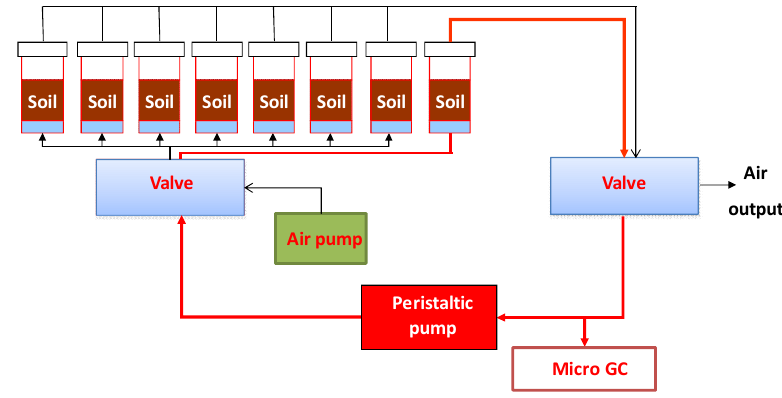
Figure 1. Diagram of the automated chromatographic system for soil CO 2 sampling and